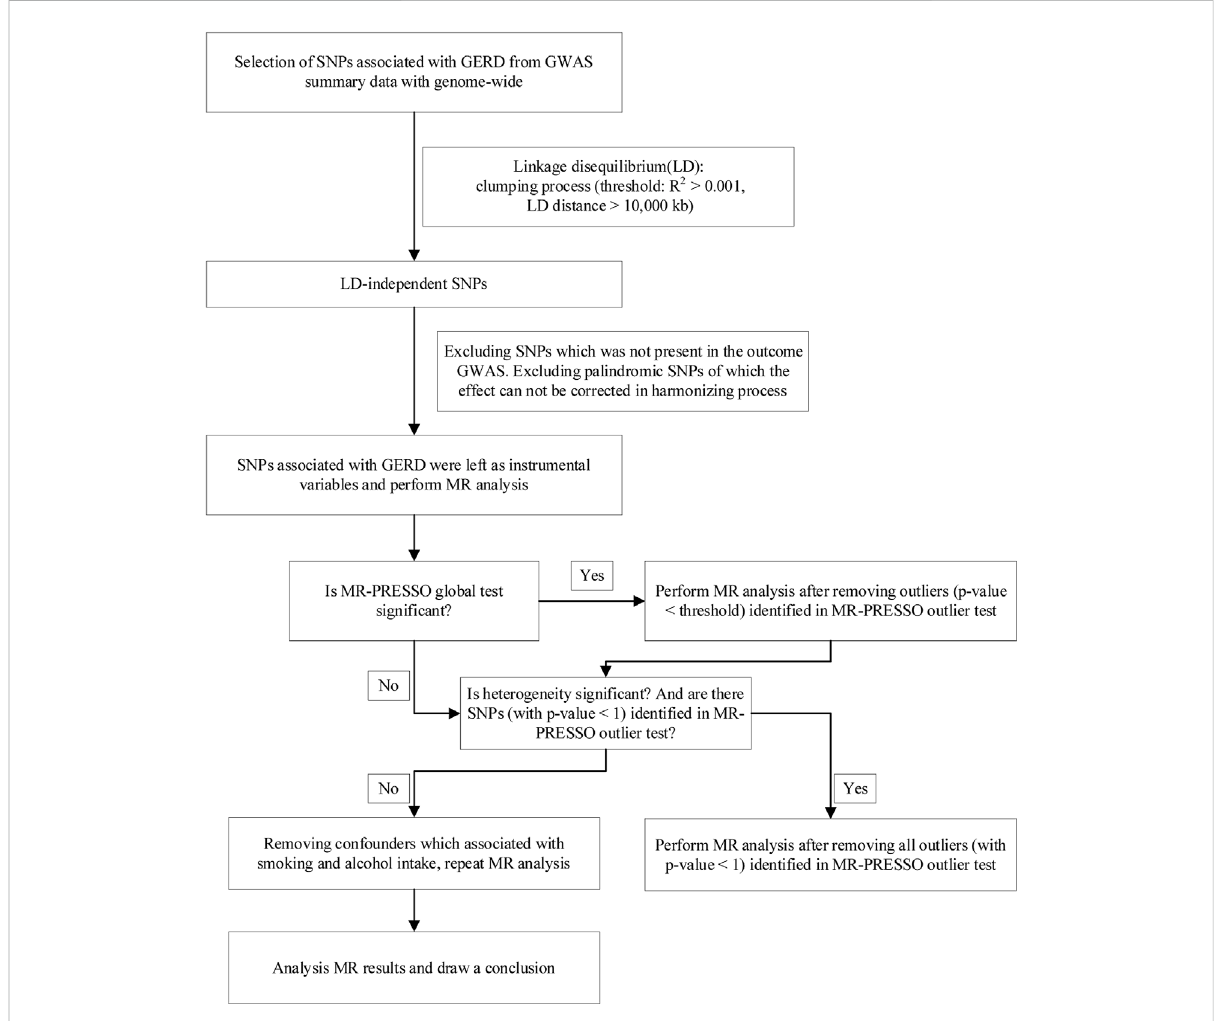
FIGURE 1 Flow chart for the analytical methods and how MR analysis was performed